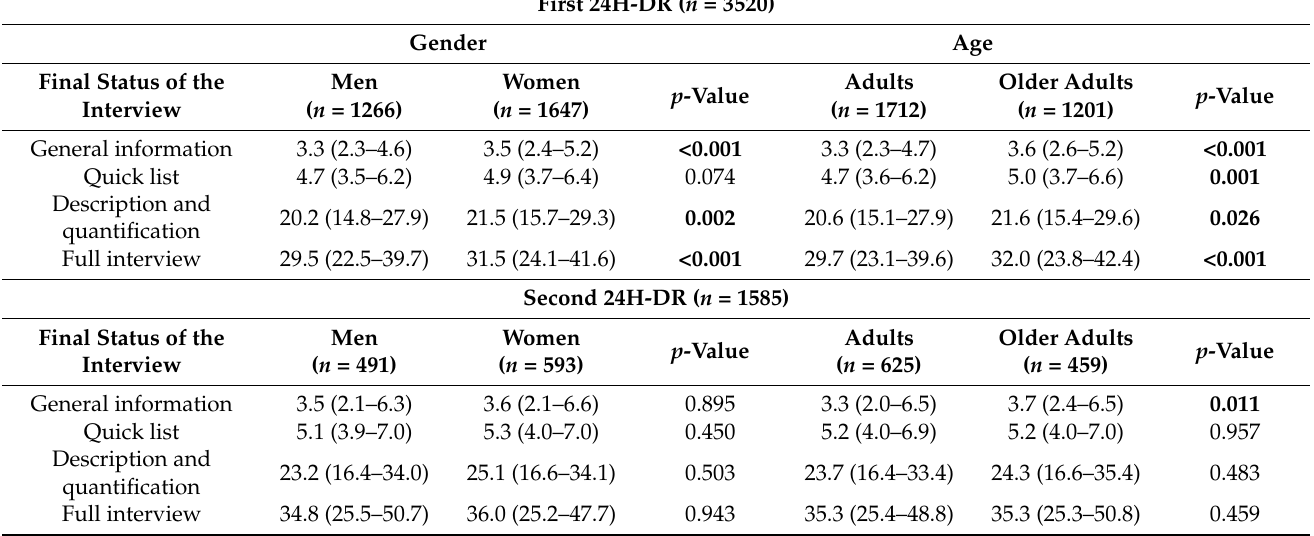
Table 5. Duration of the first (face-to-face) and the second (preferably by telephone) 24H-DR measurements, according to the gender of the participants in the third wave of